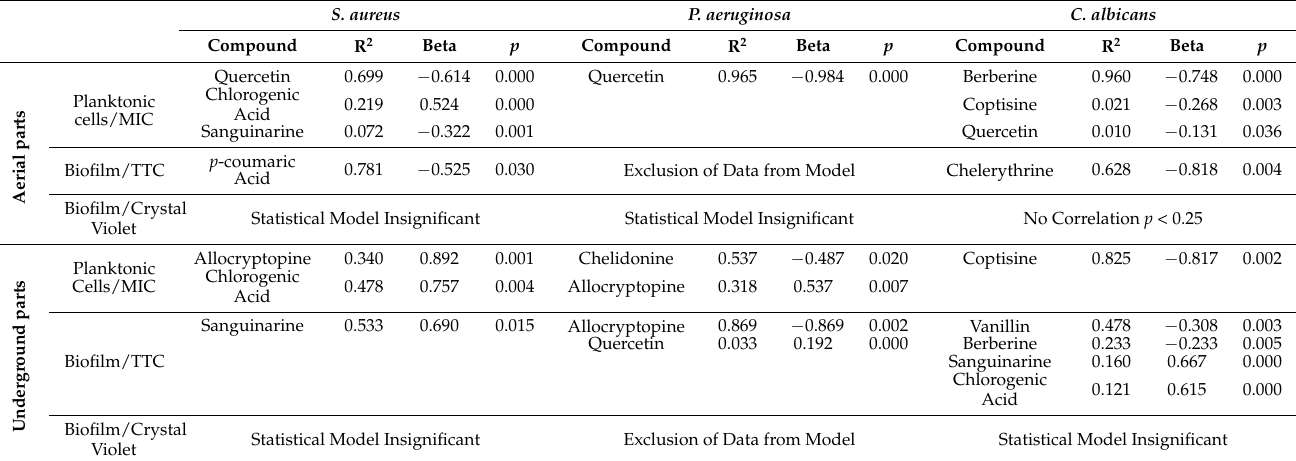
Table 4. Multiple regression-estimation of the influence of the variable on the